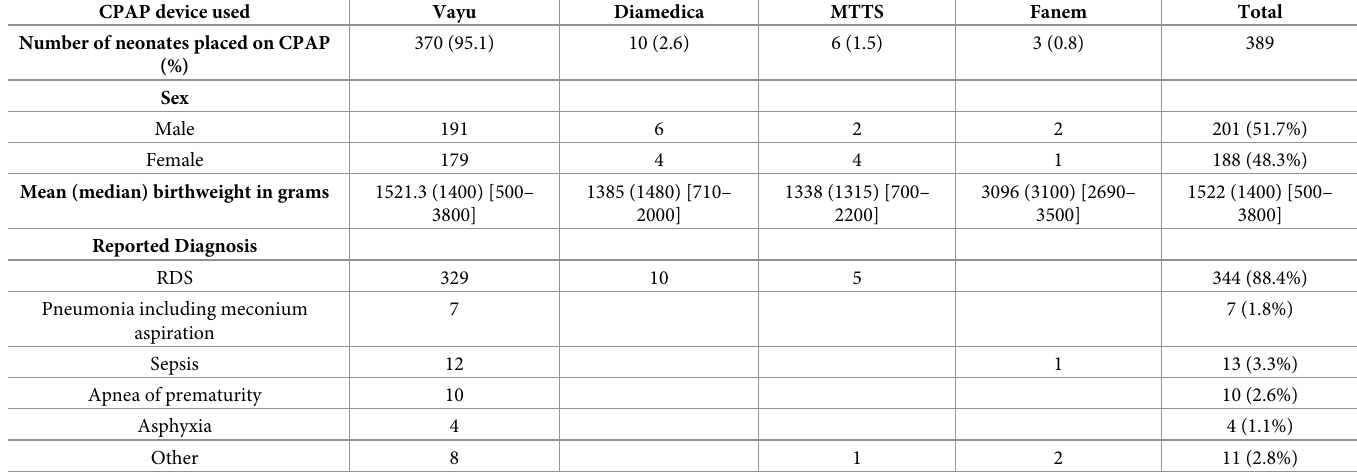
Table 1. Clinical characteristics of neonates treated with bCPAP Systems in Muhimbili National Hospital’s Newborn Unit between April 8, 2021 and October 10, 2021. CPAP device used Vayu